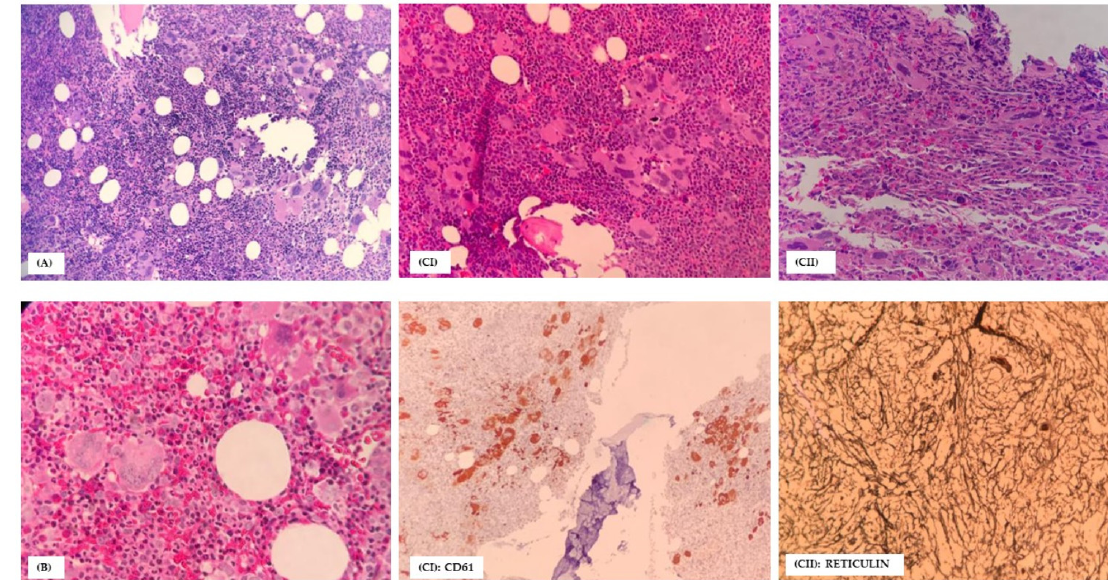
Figure 1. H& E ( A ) Polycythemia vera; hypercellularity with panmyelosis(especially erythroid precursors and prominent megakaryocytes). The florid megakaryocytes admixture of small, normal to large pleomorphic morphology and arranged in loose clusters. Dilated sinus containing red blood cells. ( B ) Essential thrombocythemia; normal in cellularity, proliferation of abnormally giant or large form of atypical megakaryocytes, abundant cytoplasm, scattered throughout the marrow spaces. Erythropoiesis and granulopoiesis were within normal. ( C ) Primary myelofibrosis; ( CI ) pre-PMF: hypercellularity with a proliferation of atypical megakaryocytic arranged in dense or large clusters and usually adjacent to vascular sinus and bony trabeculae. Megakaryocytes morphology (high nuclear-cytoplasmic ratio, abnormal chromatin clumping, ( CII ) Overt PMF: Variable cellularity with (sometimes) absence of hematopoietic cells, dense reticulin, atypical megakaryocytes, usually in sheets and within the dilated